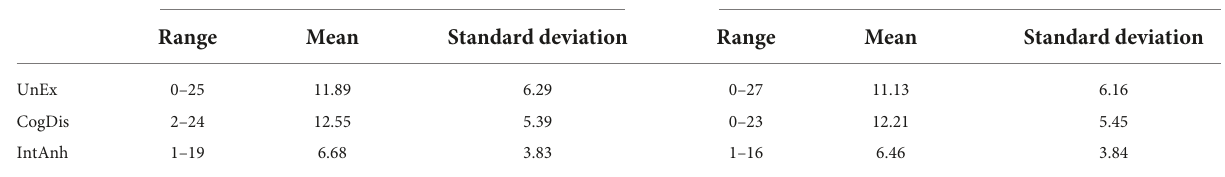
TABLE 1 Descriptive statistics for the three dimensions on the Oxford-Liverpool Inventory of Feelings and Experiences (O-LIFE) included in the analyses. Experiment 1: geometric task Experiment 2: non-geometric task